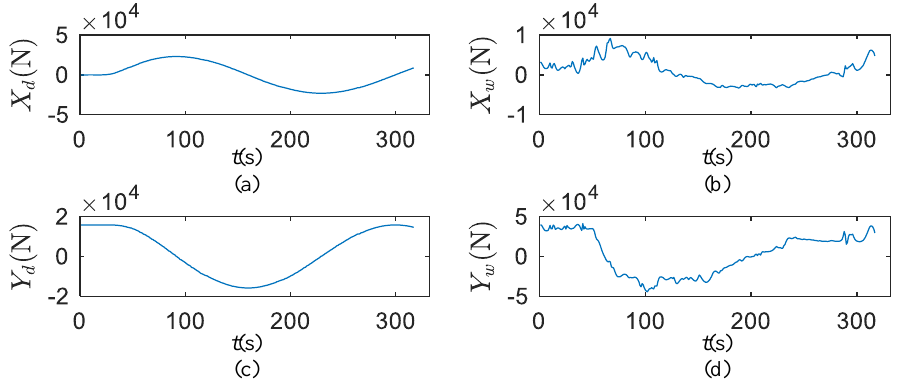
Figure 6. Wind load and wave drift force for +20°turning circle test. ( a ) Surge force induced by wave; ( b ) surge load induced by wind; ( c ) sway force induced by wave; ( d ) sway load induced by wind. In the calculation of Figure 6, the ship front projected area, A , is 1304.6 m 2 . The longitude centroid position of area, lw position is 6.8 m.